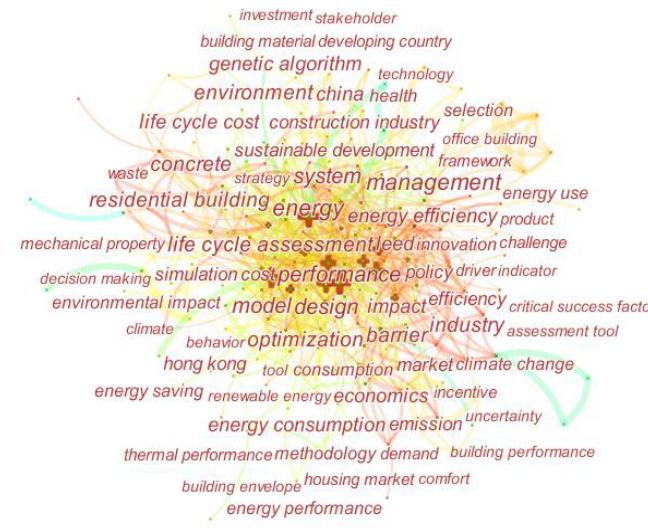
Figure 2. Keyword co-occurrence network.